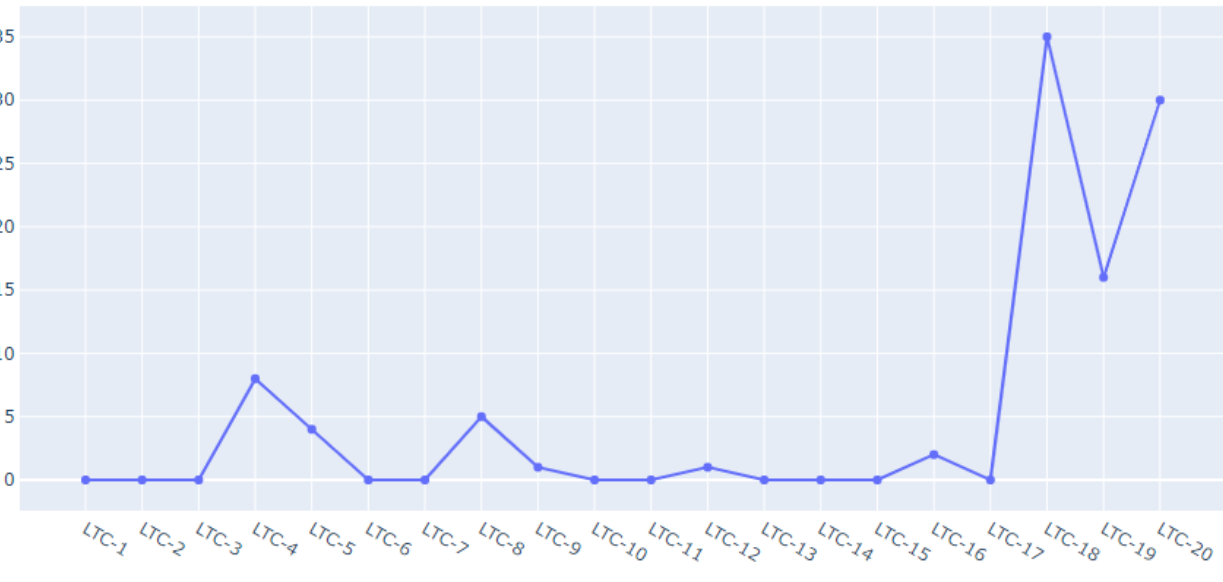
Figure 2. The number of residents using social networking after the COVID-19 pandemic. The number of people who had used social networks in elderly care